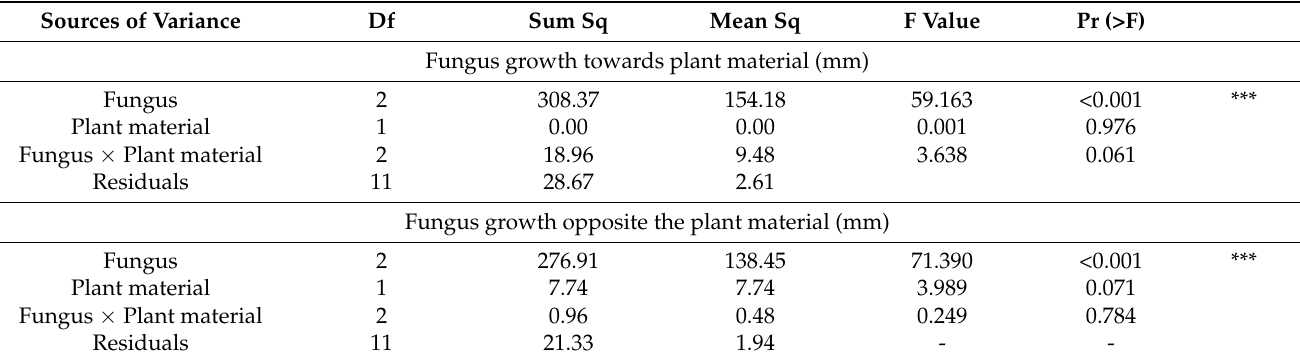
Table 1. Analysis of variance for fungi growth towards and opposite the plant material. Df—degrees of freedom, Sum Sq—sum of squares, Mean Sq—mean square, F value—F statistic, Pr (>F)— p -value, ***-statistically significant results, Fungus—analysed fungi ( Hymenocyphus fraxineus , Thielavia basicola , Minimidochium sp.); Plant material—type of plant material (non embryogenic callus tissue, seedling); Fungus × Plant material—interaction between fungus and plant material ( Hymenocyphus fraxineus × seedling, Hymenocyphus fraxineus × non embryogenic callus tissue, Thielavia basicola × seedling, Thielavia basicola × non embryogenic callus tissue, Minimidochium × seedling, Minimidochium × non embryogenic callus tissue).